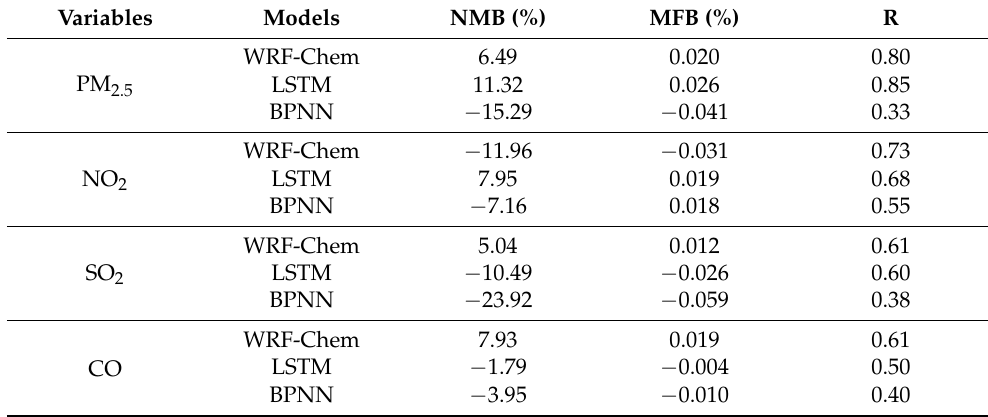
Figure 8. Time series of the simulated and observed hourly PM 2.5 , NO 2 , SO 2 , and CO concentrations for Guangzhou. Black circles represent the observations, red lines represent the WRF-Chem simulations, blue-dashed lines represent the LSTM simulations, and brown-dashed lines represent the BPNN simulations. Table 6. Evaluations of the simulated pollutant concentrations in Guangzhou for the different